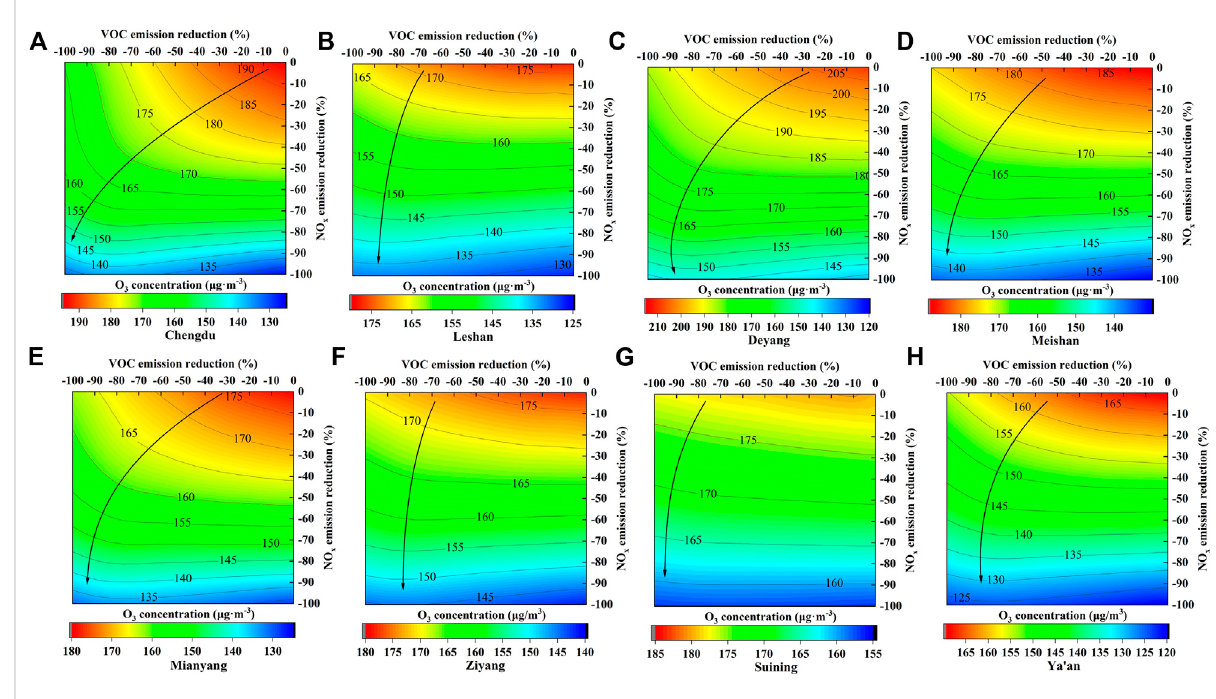
FIGURE 5 Isopleth diagrams of MDA8 O 3 varing with VOCs and NO x emission reductions for the CMA scenario ( (A) Chengdu, (B) Leshan, (C) Deyang, (D) Meishan, (E) Mianyang, (F) Ziyang, (G) Suining, (H) Ya ’ an; the black lines with arrows are